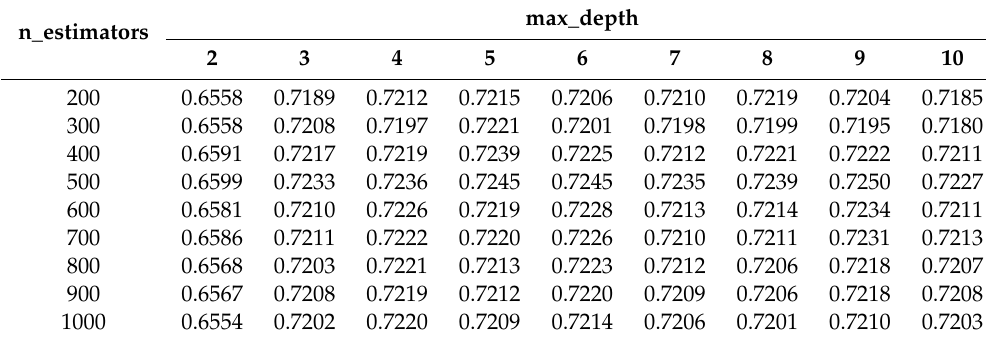
Table 4. The ten-fold cross validation for the proper parameters in the random forest.